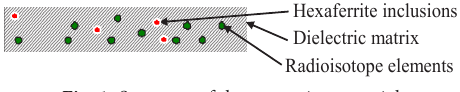
Fig. 1. Structure of the protective material